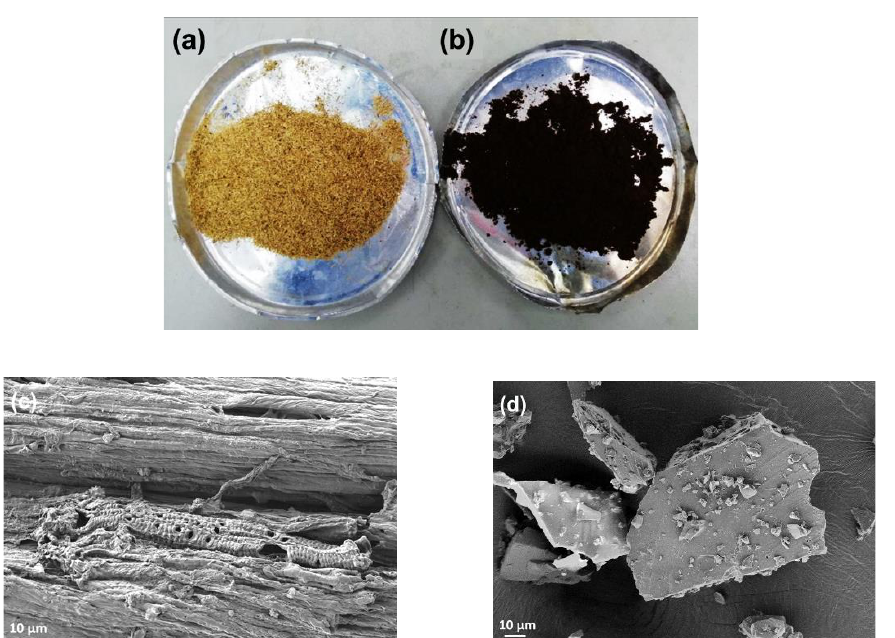
Figure 1. Structure of ( a ) OPEFB fibers ( b ) extracted lignin and the micrograph of ( c ) OPEFB after extraction ( d ) organosolv lignin.